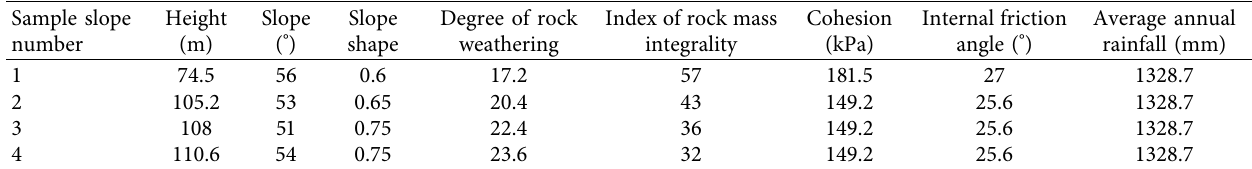
Figure 4: Profile distribution map for the slope stability evaluation in Tonglvshan open-pit mine. Table 3: Partial evaluation index values of slope